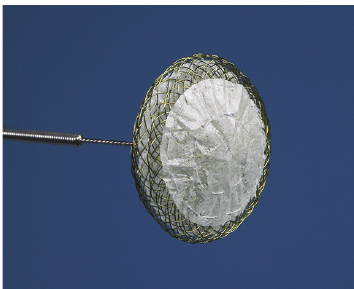
Figure 1: View of the Occlutech Figulla PFO device (23/25mm) prior to implantation.